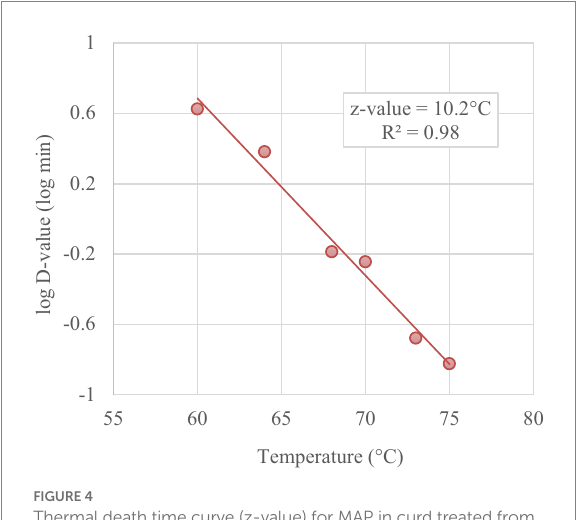
FIGURE 4 Thermal death time curve (z-value) for MAP in curd treated from 60 ° C to 75 ° C obtained by D -values in a log scale (symbols) as function of treatment